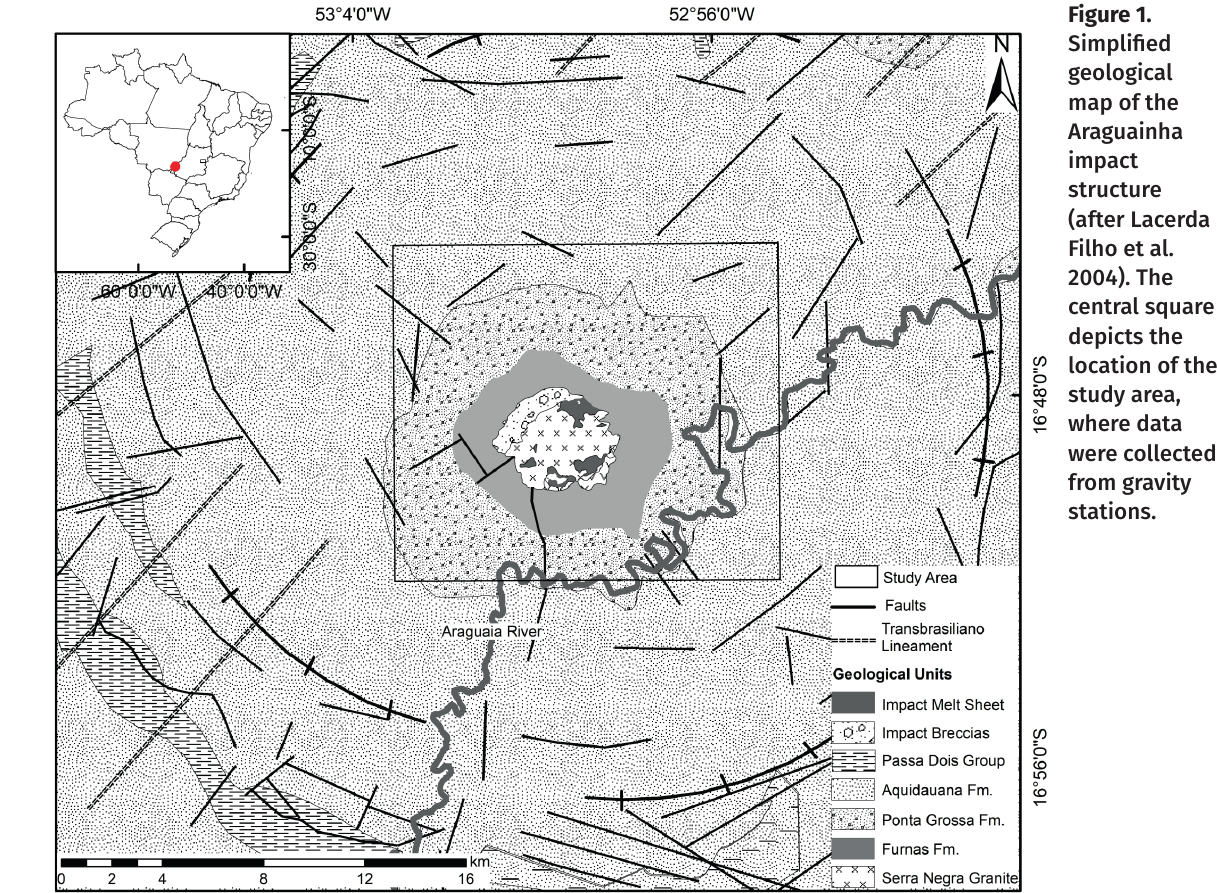
Simplifi ed geological map of the Araguainha impact structure (after Lacerda Filho et al. 2004). The central square depicts the location of the study area, where data were collected from gravity